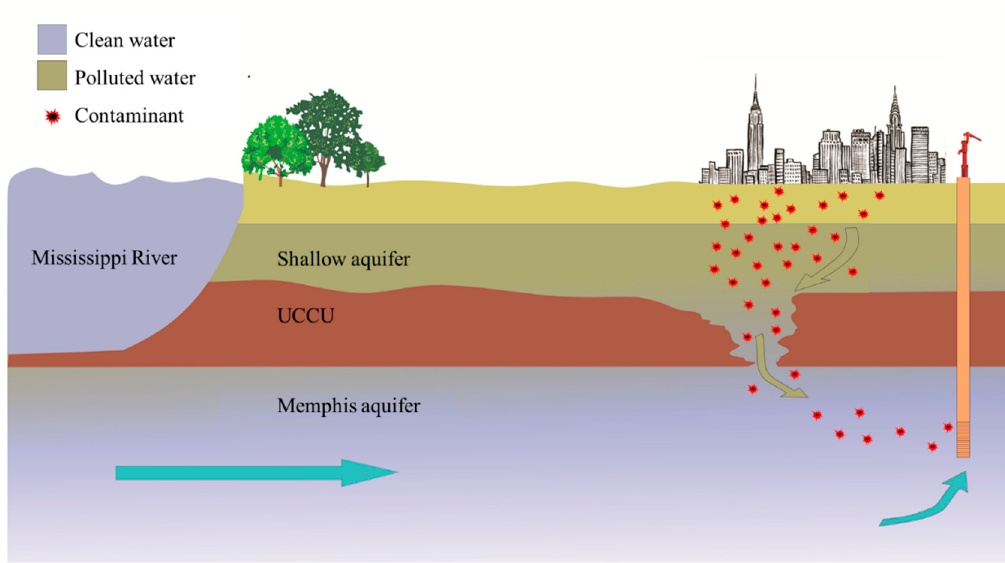
Figure 2. The methods by which pollution can be transferred from urban activities to the Shallow aquifer, and finally to the Memphis aquifer, through a breach.